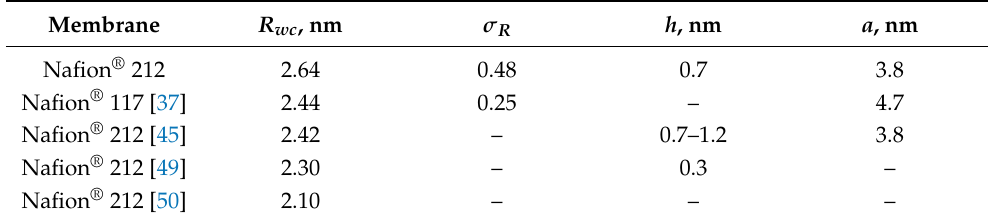
Table 2. Structural parameters of the ionic domains of the Nafion ® membrane swollen in water: the radius of the ionic domains ( R wc ), standard deviation of the radii distribution ( σ R ), thickness of the domain shell ( h ), and the distance between ionic domains ( a